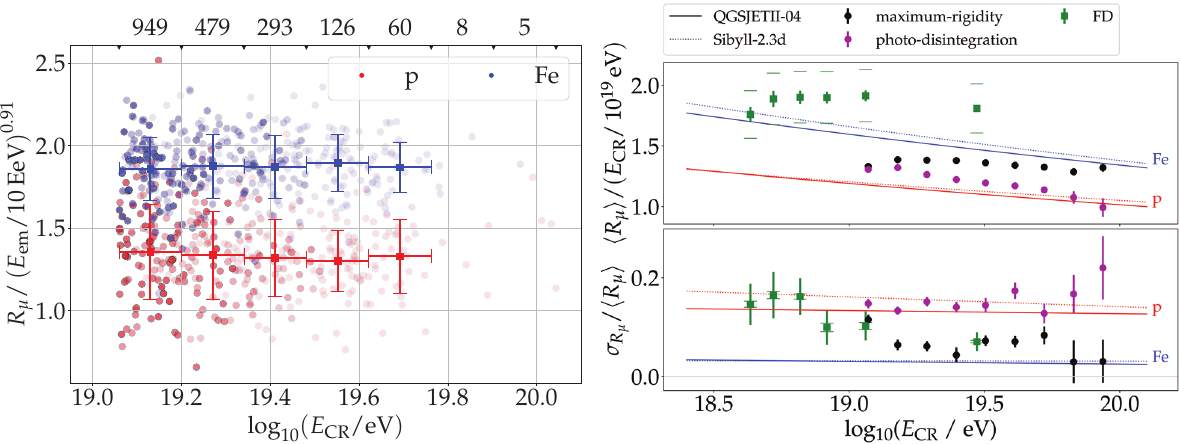
Figure 7. Left: Separation power between proton and iron primaries of the relative muon number normalized by the electromagnetic energy as a function of cosmic-ray energy. Right: Discrimination power between to di ff erent mass composition scenarios using the mean muon number (top) and the fluctuations in the number of muons (bottom) for combined measurements with the Auger Radio and Water Cherenkov Detectors in 10 years. In green, for comparison, measurements made previously with the Auger Fluorescence and Water Cherenkov